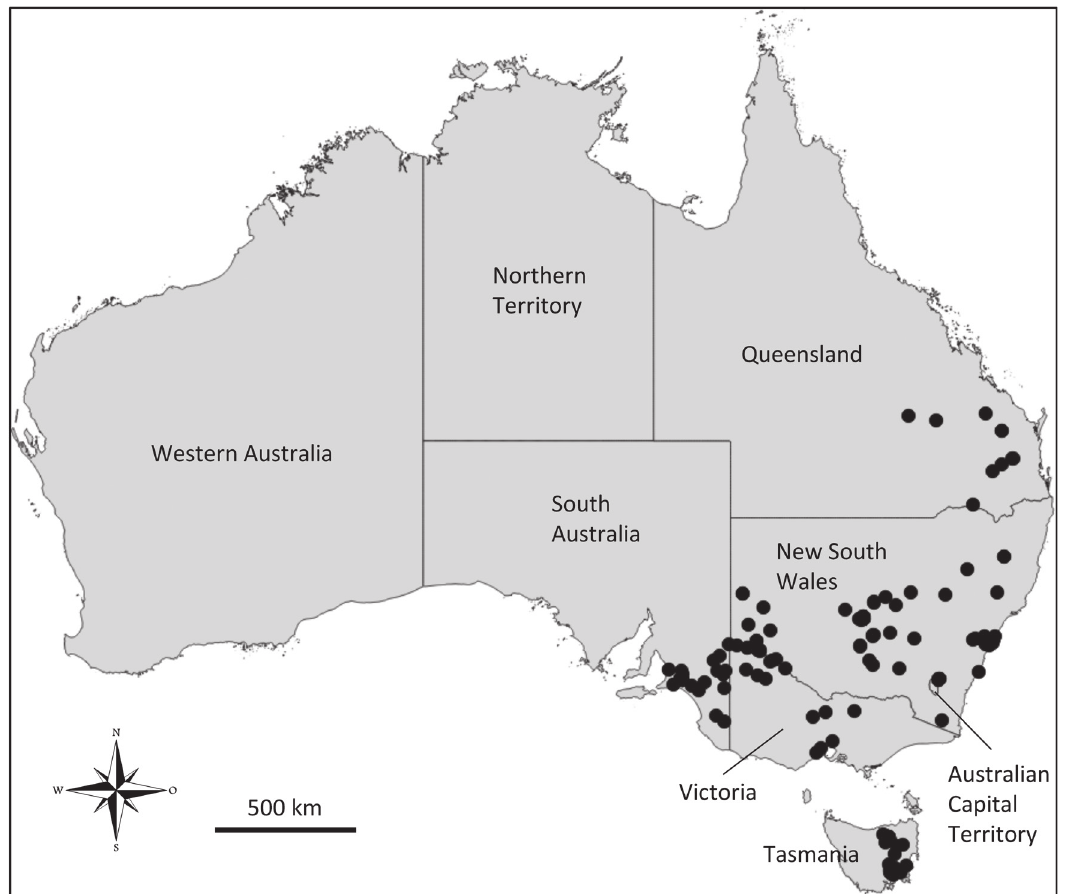
Figure 5. Distribution records of Portacosa cinerea gen. n. and sp. n. in Australia.